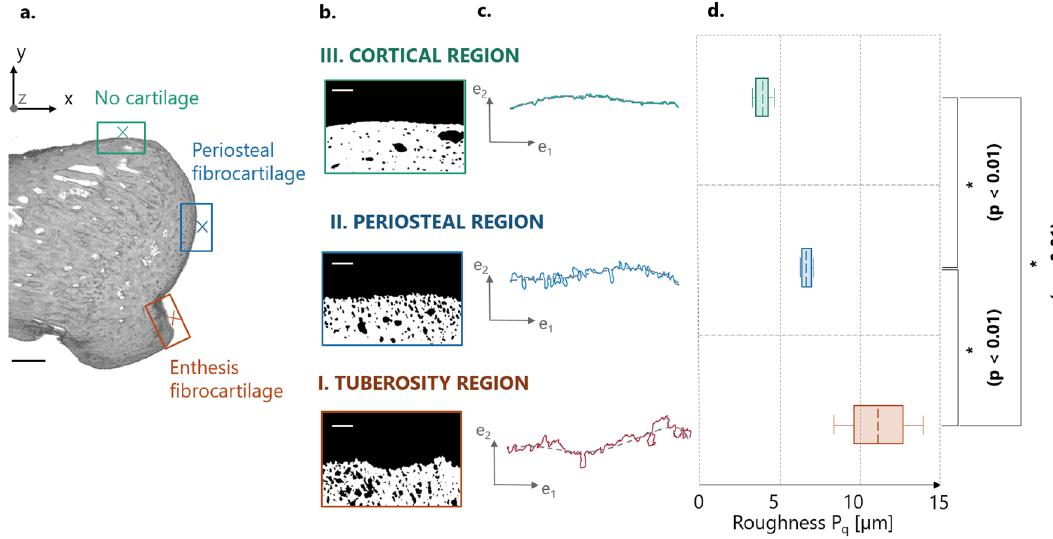
Figure 8. Roughness of the interface profile line based on the high-resolution micro-CT scans. ( a ) Regions of interest (ROI) on a representative bone cross section. ( b ) ROI after extraction and binarization. ( c ) The full line represents surface profile whereas the dashed line shows the reference line used to compute the roughness. e 1 and e 2 are local direction vectors. ( d ) Surface roughness (expressed as root mean square P q ) calculated in the three ROI including the interface between mineralized and unmineralized enthesis fibrocartilage (I. Tuberosity region), the interface between mineralized and unmineralized periosteal fibrocartilage (II. Periosteal region) and the outer cortical bone surface (III. Cortical region). Box plots extends from 25 to 75th percentiles and whisker bars covers the full data range. The dashed line represents the mean value. Scale bars: 500 µm (in A, black), 100 µm (in B, white). Statistically significant p values (p < 0.05) are shown in